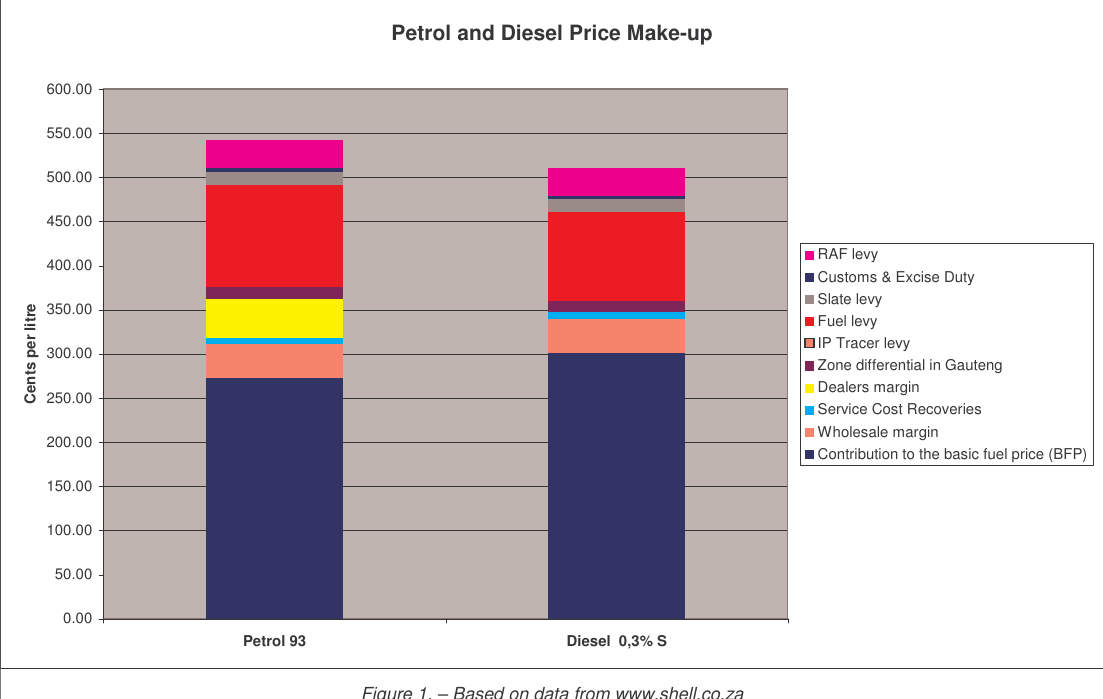
Figure 1: Petrol and diesel price make-up Petrol and Diesel Price Make-up